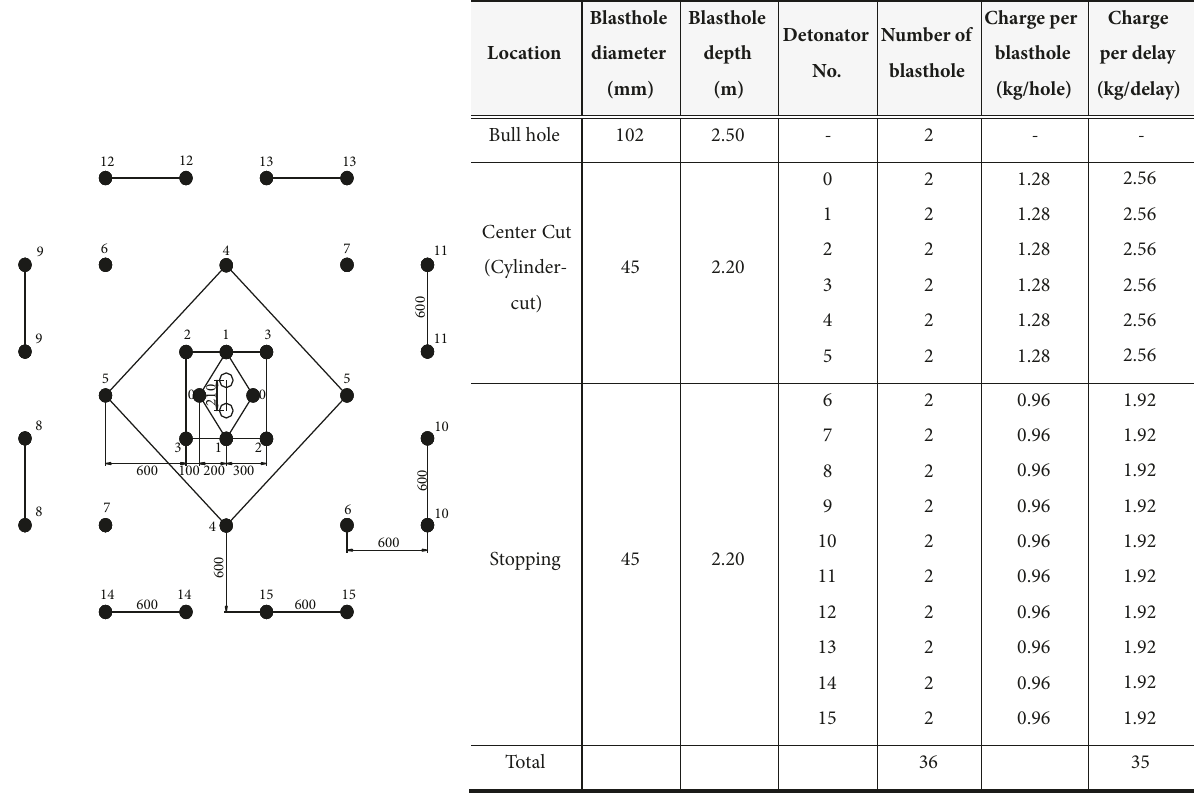
Figure 5: Blasting pattern (cylinder-cut, real scale) (Test